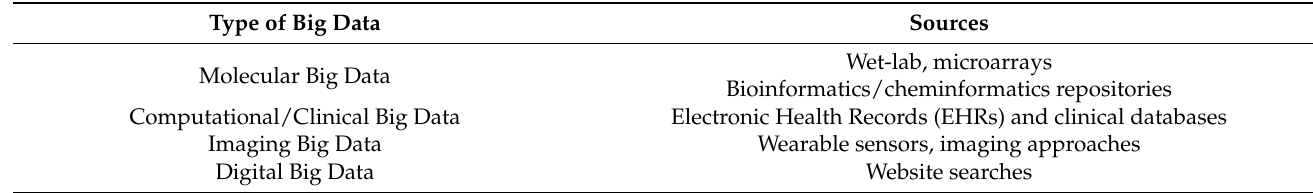
Table 1. An overview of the different kinds of Big Data. Type of Big